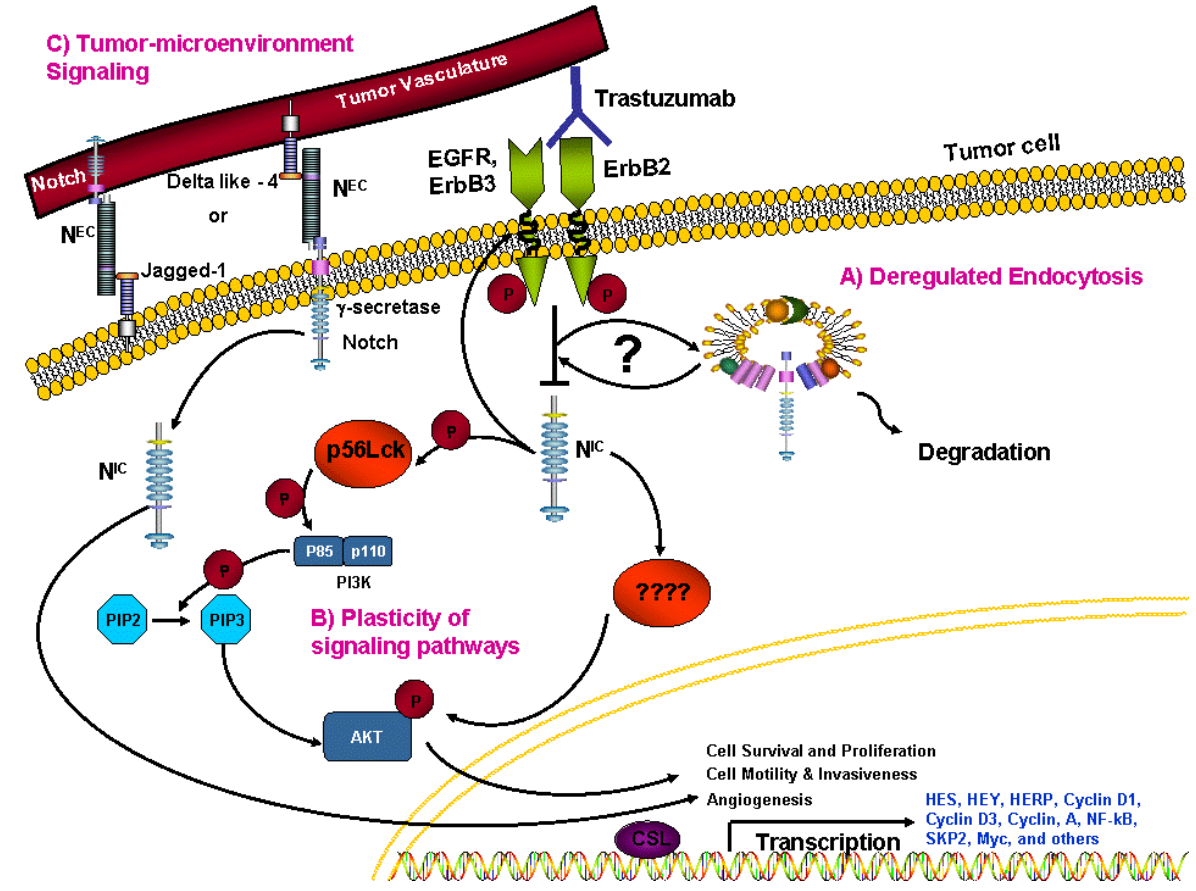
FIGURE 1. Possible mechanisms by which Notch is activated and contributes to trastuzumab resistance. (A) ErbB-2 may suppress Notch-1 signaling by retention of Notch-1 and Jagged-1 within endosomes, which may be reversed upon trastuzumab treatment. Activated Notch-1 could evade ErbB-2–targeted therapy by (B) activating the PI3K-AKT pathway via p56 Lck , and this functions to increase cell survival and proliferation due to plasticity of signaling pathways, or by (C) initiating a cross-talk between the tumor and its surrounding microenvironment, and promoting angiogenesis and tumor